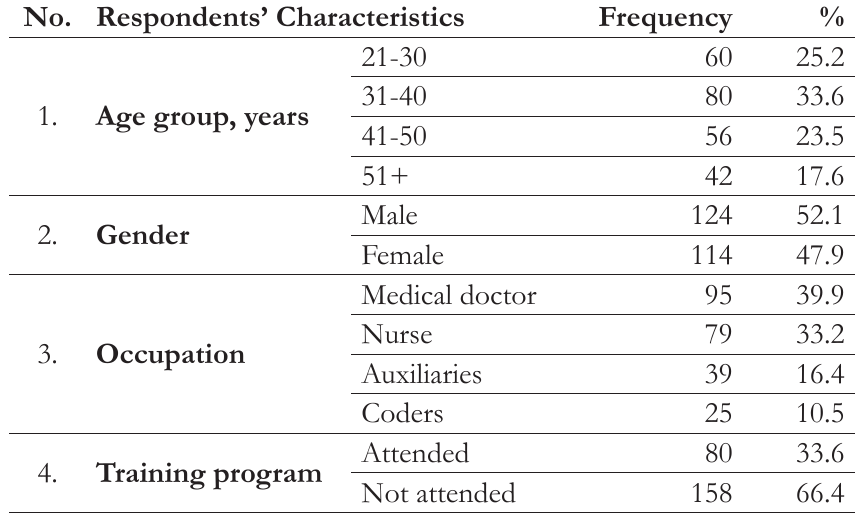
Table 1. Frequency Distribution of Socio-demographic Characteristics of Respondents